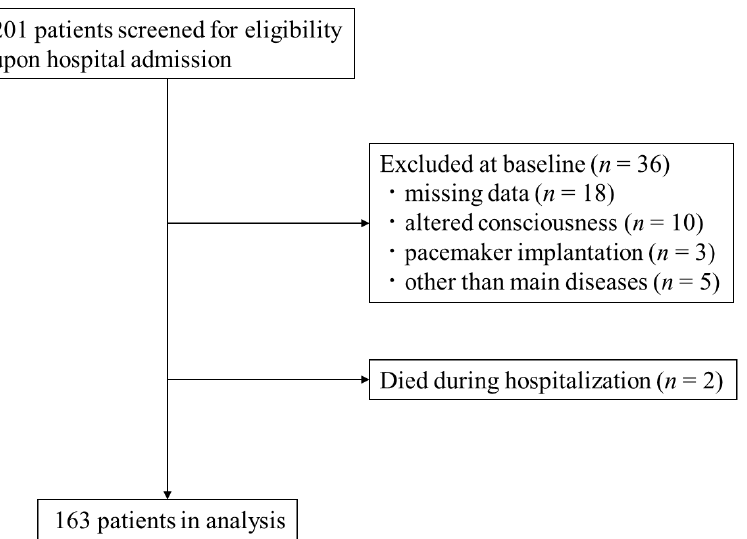
Figure 1. Flowchart of the study population.